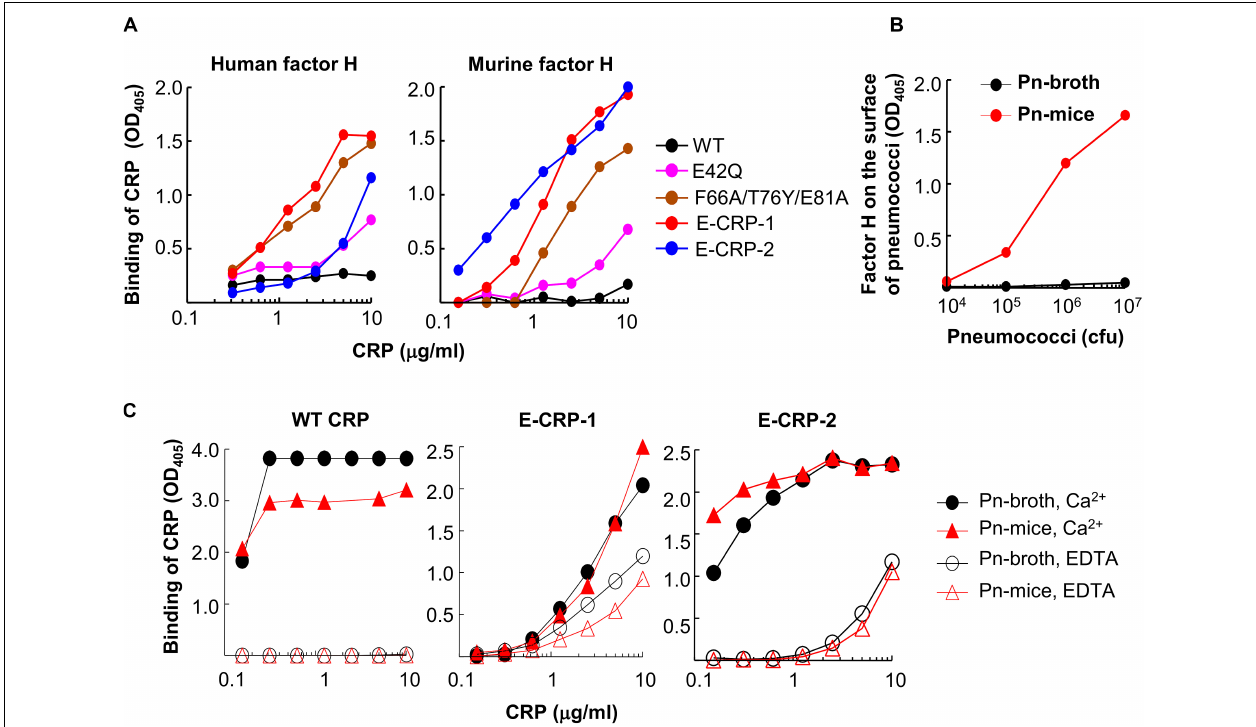
FIGURE 3 | Binding of CRP to factor H. (A) Binding of WT CRP, E-CRP-1, E-CRP-2 and other CRP mutants to purified human factor H (left panel) and murine factor H (right panel) immobilized on microtiter wells. (B) Presence of murine factor H on pneumococci isolated from the blood of infected mice (Pn-mice). (C) Binding of WT CRP, E-CRP-1 and E-CRP-2 to Pn-broth and Pn-mice in the presence and absence of Ca 2 + . A representative of three experiments is shown for each panel.